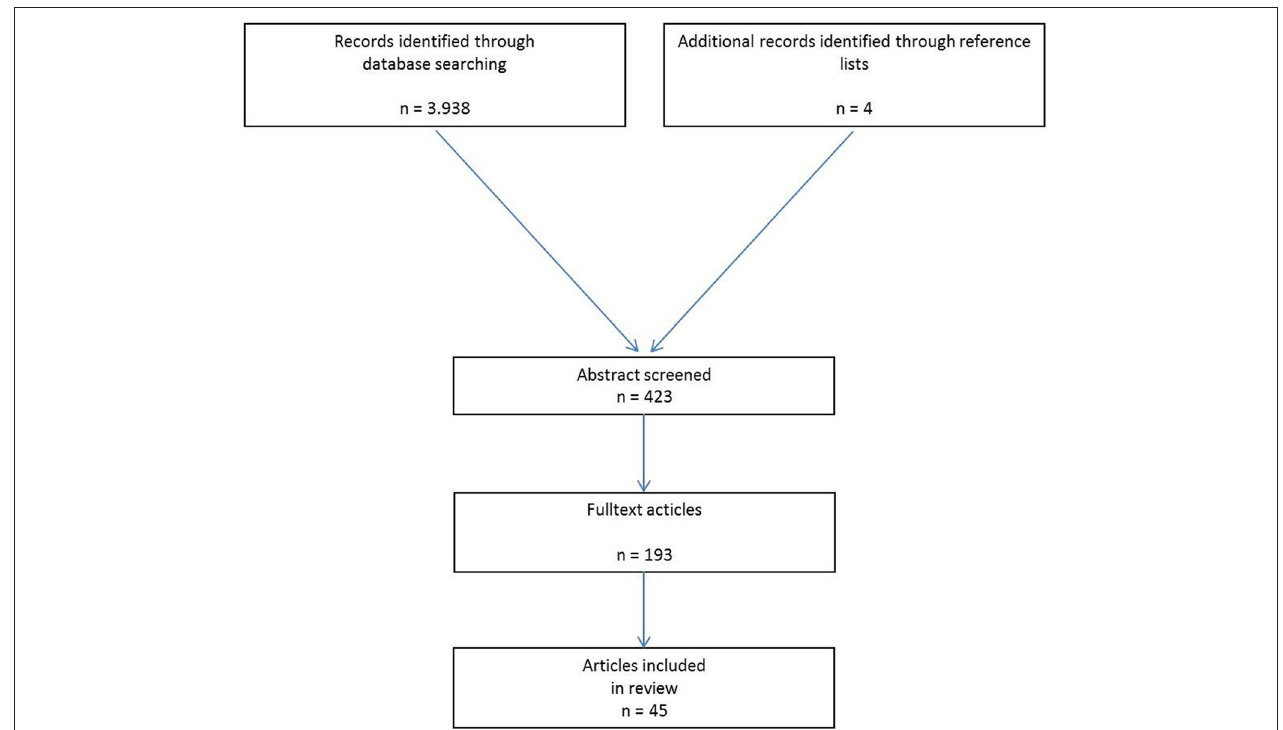
FIGURE 1 | Flowchart of article